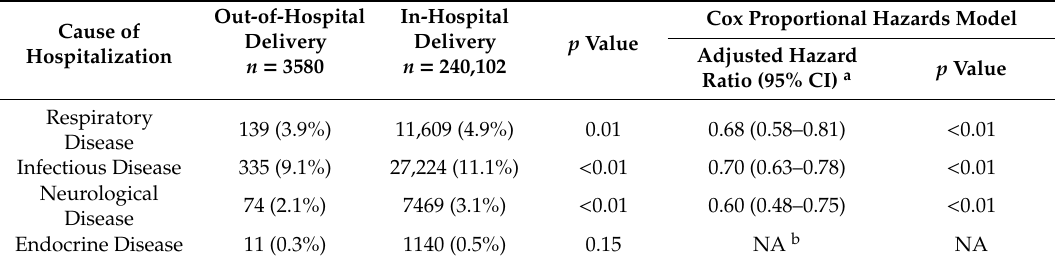
Table 4. Hospitalization rates among o ff spring of mothers with unplanned out-of-hospital delivery compared to in-hospital